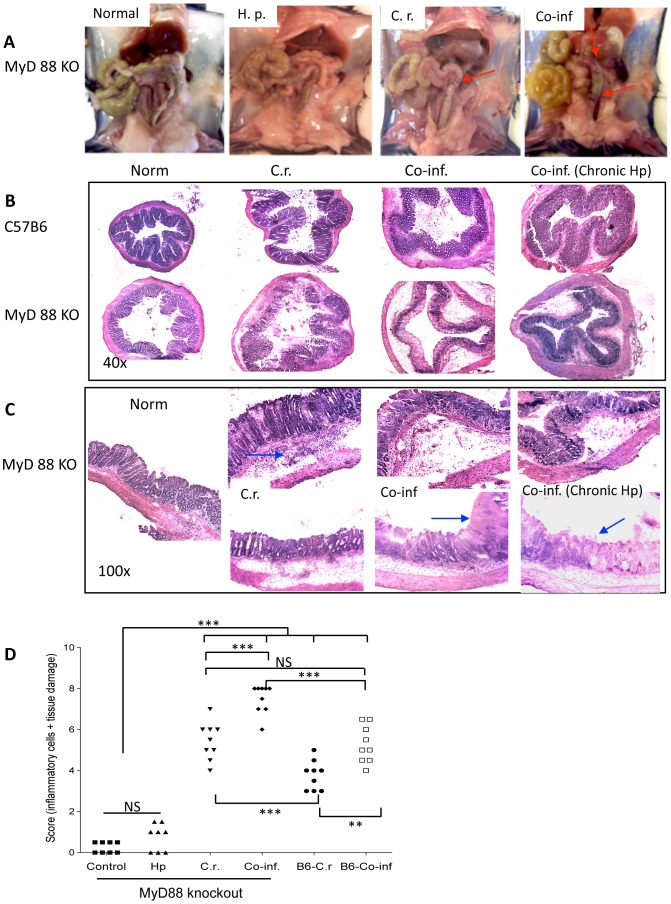
Helminth co-infection exacerbates C. rodentium-induced colitis and intestinal injury in MyD88 knockout mice.
A. Macroscopic examination of colon tissues of MyD88 knockout mice from different treatment groups. Arrows indicate intestinal bleeding. B. Colon tissues were removed from uninfected mice or from mice infected with H. polygyrus, C. rodentium, or both two weeks after bacterial infection, frozen in Tissue Tek OCT compound, and the sections were stained with hematoxylin and eosin. B: Magnification, ×40 and C: Magnification, ×100. Duplicate samples are presented from co-infected and C. rodentium-infected MyD88 knockout mice. Co-inf (chronic): C57BL/6 and MyD88 knockout mice were pre-infected with H. polygyrus for 3 weeks and then co-infected with C. rodentium. Arrows indicate cellular infiltration and loss of intestinal architecture. D. Histopathological score of colonic inflammation in mice infected with C. rodentium or both. The scores were assessed by determination of infiltration of inflammatory cells (score range, 0 to 4), together with the evaluation of cecal tissue damage (score range, 0 to 4). The data shown are pooled from three independent experiments with total (n = 9 to 12 per group). *** p<0.001, **p<0.005.